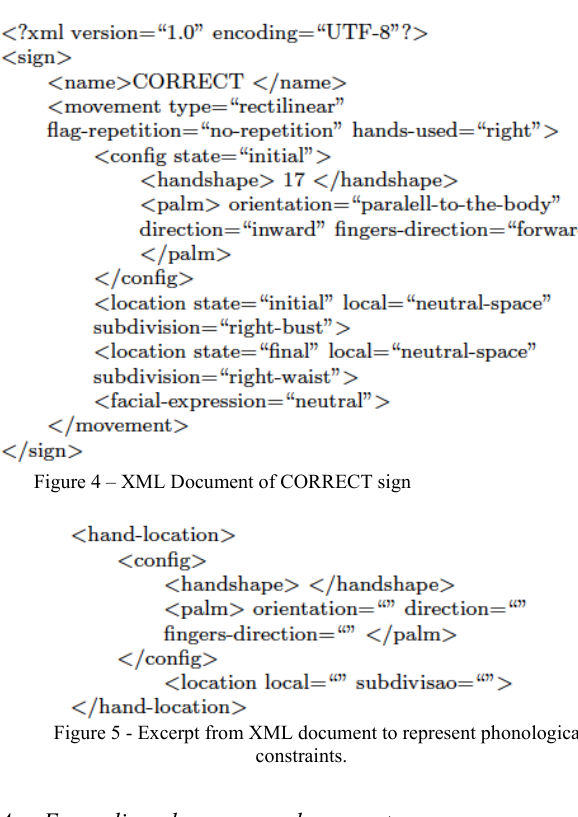
FigurE 7 – XML Document of Descriptor to include a new